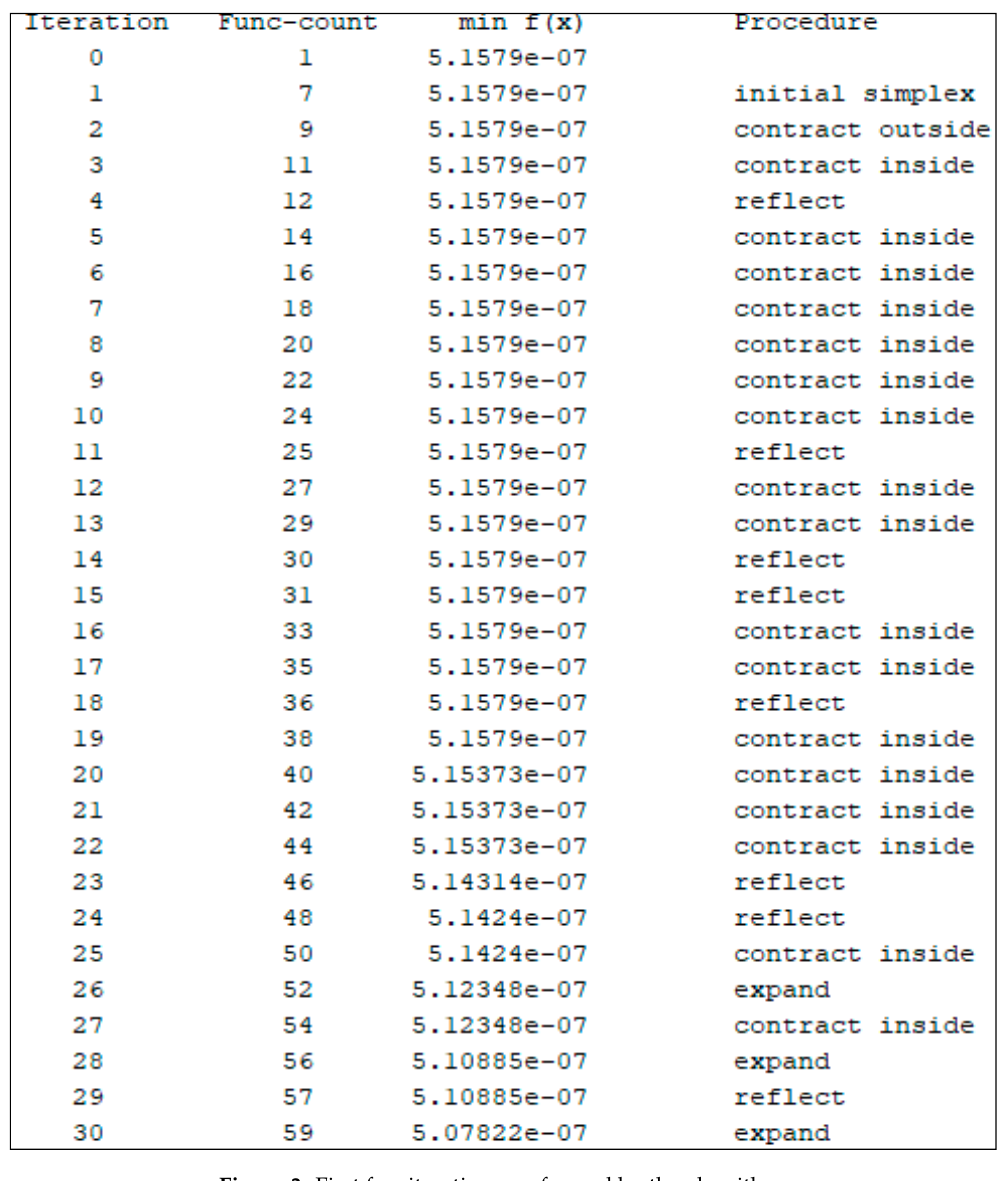
Figure 3. First few iterations performed by the algorithm. Table 1. Unoptimized and optimized digital controllers transfer functions.